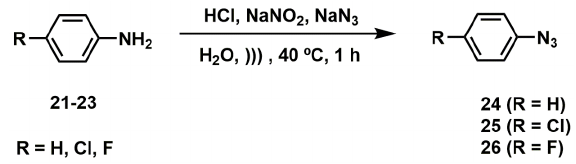
Table 4. Optimization of reaction conditions for the synthesis of compounds 17 – 20 . 1,2.